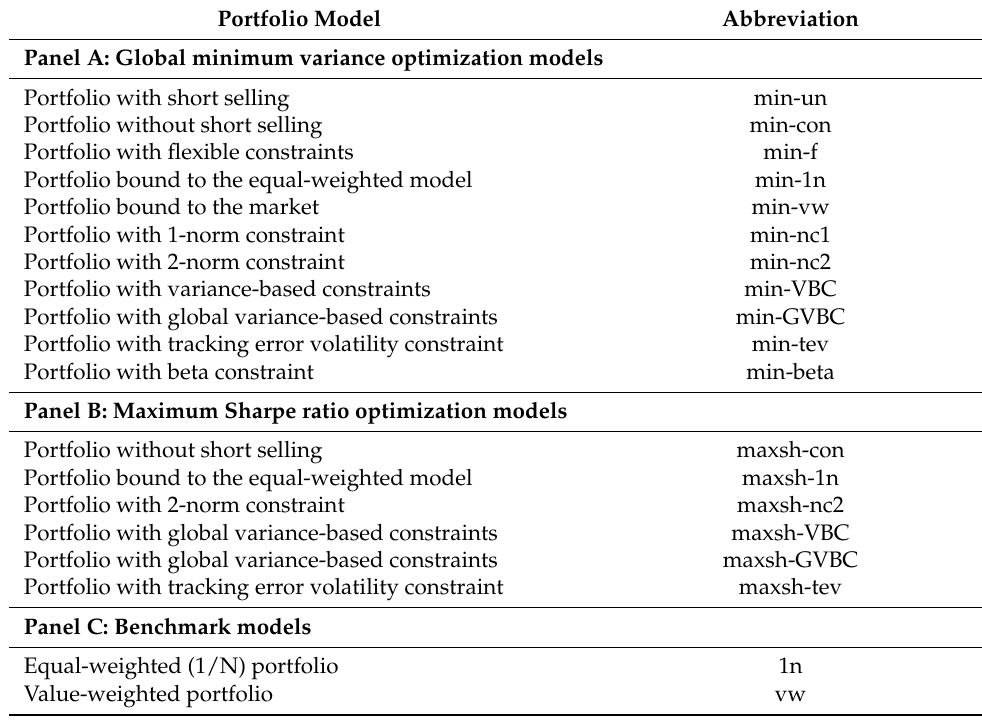
Table 2. List of portfolio